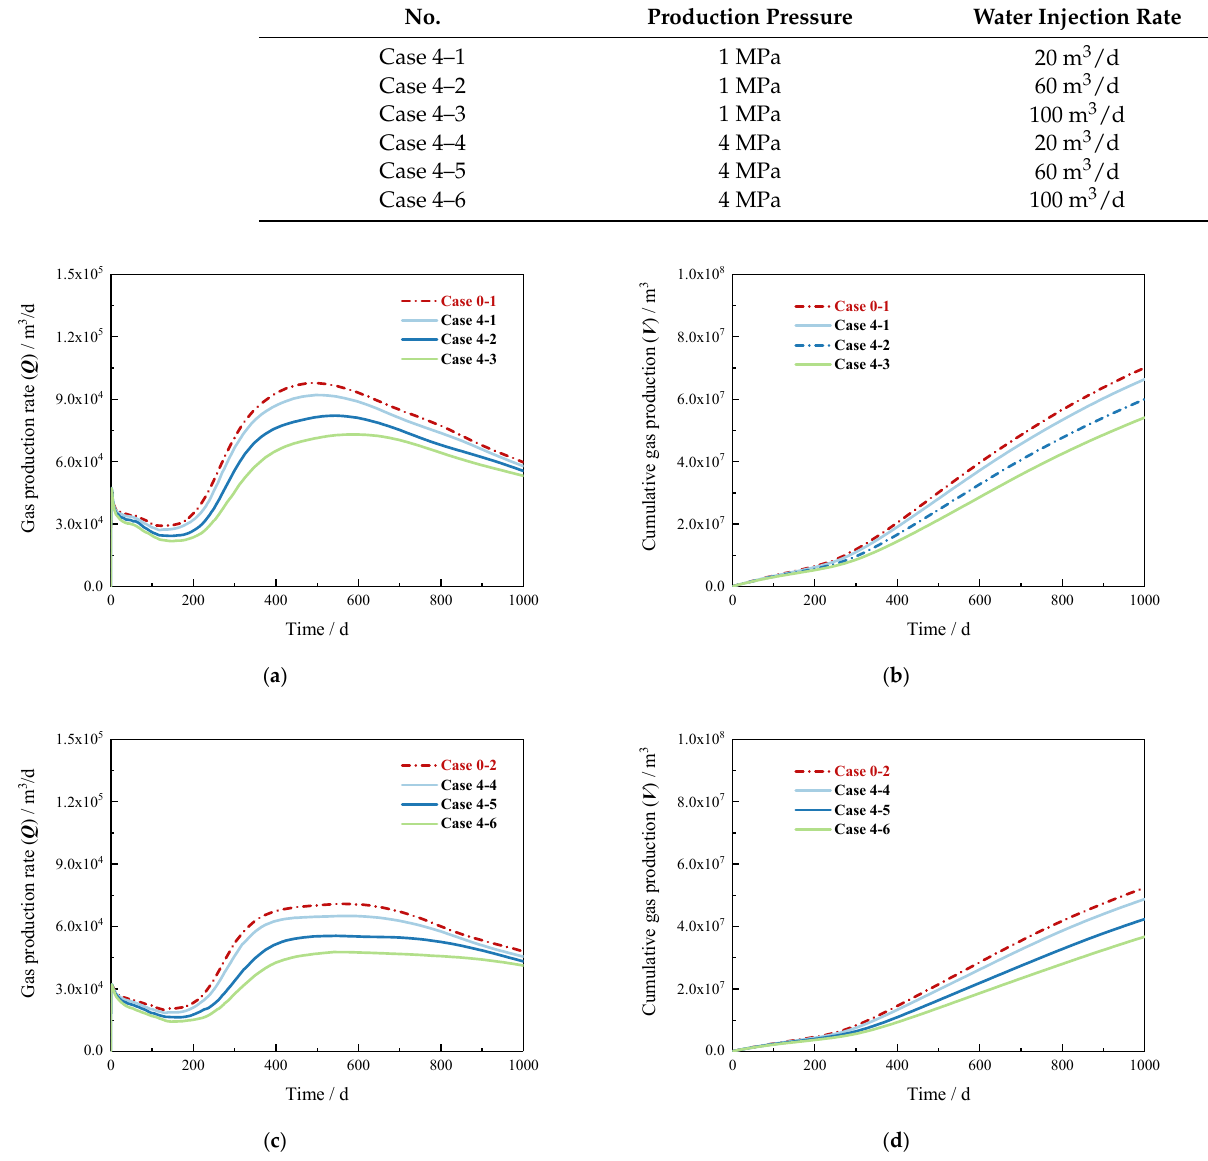
Figure 11. Gas production characteristics for the depressurization combined thermal stimulation: ( a ) gas production rate (1 MPa); ( b ) cumulative gas production (1 MPa); ( c ) gas production rate (4 MPa); and ( d ) cumulative gas production (4 MPa).